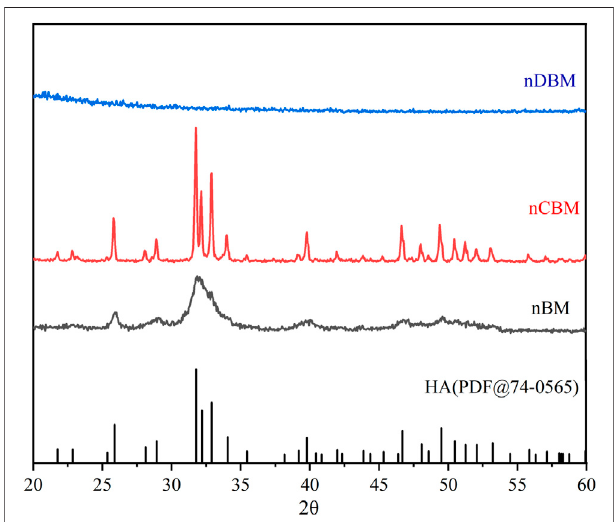
FIGURE 3 | XRD patterns of different nano bone powders.